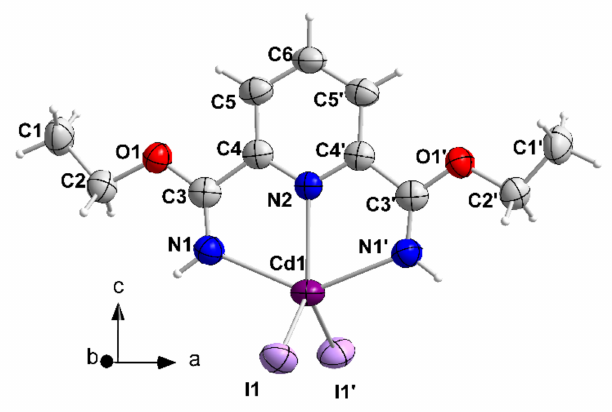
Figure 10. Layers of molecules [CdI 2 (dapdoH 2 )] parallel to the (001) plane in the crystal structure of 4 · 2EtOH. The thick dashed dark and light green lines represent π - π interactions. The thick dashed cyan and brown lines represent the C4-H(C4)-I2 and C9-H C (C9) ... O2 hydrogen bonds, respectively. The hydrogen bonds involving the lattice EtOH molecules have not been drawn for clarity reasons; for more details see the above text and Table S1.